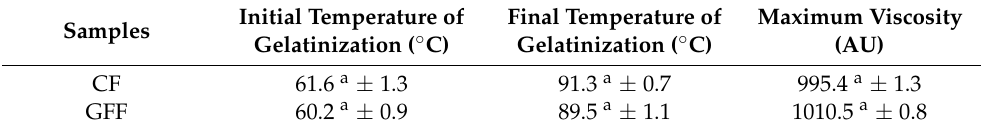
Table 4. Pasting properties of control flour (CF) and Gluten Friendly™ flour (GFF) 1 .